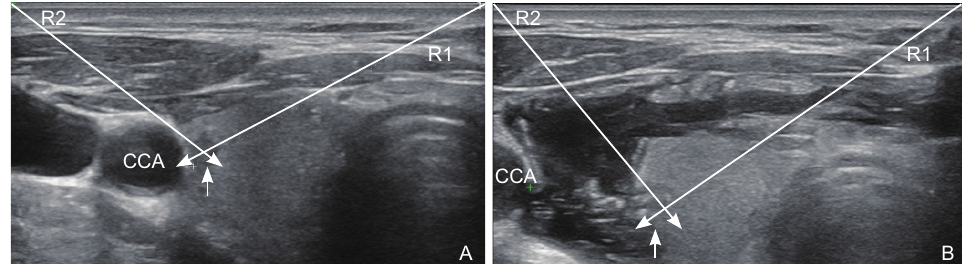
Figure 20 Liquid isolation can improve the safety of FNA. (A) The target nodule (indicated by the up arrow) is close to the common carotid artery (CCA). No matter through the R1 or the R2 route, the puncture needle is more likely to injure the common carotid artery; (B) With liquid isolation, the distance between the target nodule (indicated by the up arrow) and the common carotid artery (CCA) increases, the puncture needle can avoid injuring the common carotid